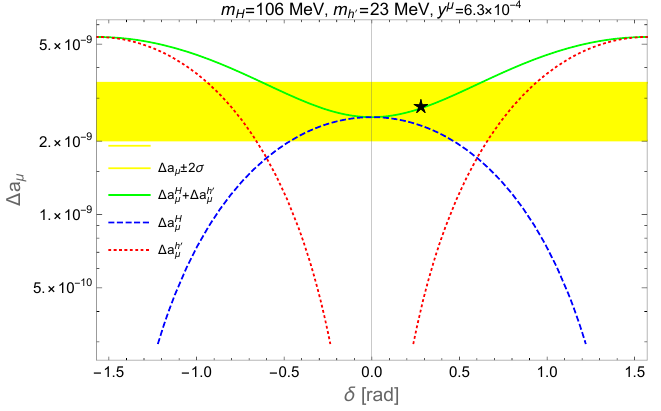
Figure 4 . Muon anomalous magnetic moment versus the scalar mixing angle δ , along with our benchmark in table 1 denoted by the black